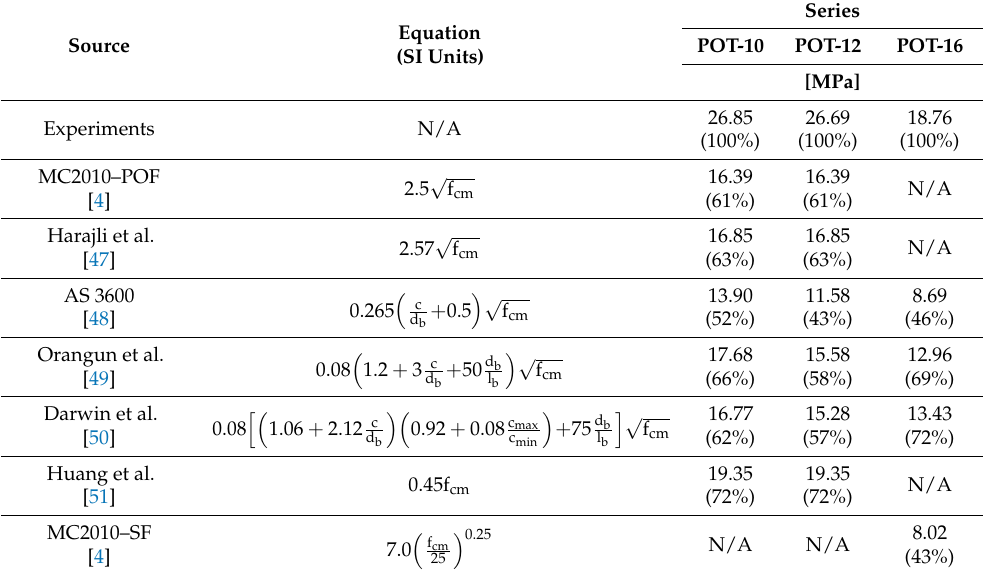
Table 13. Parametric analysis of maximum bond